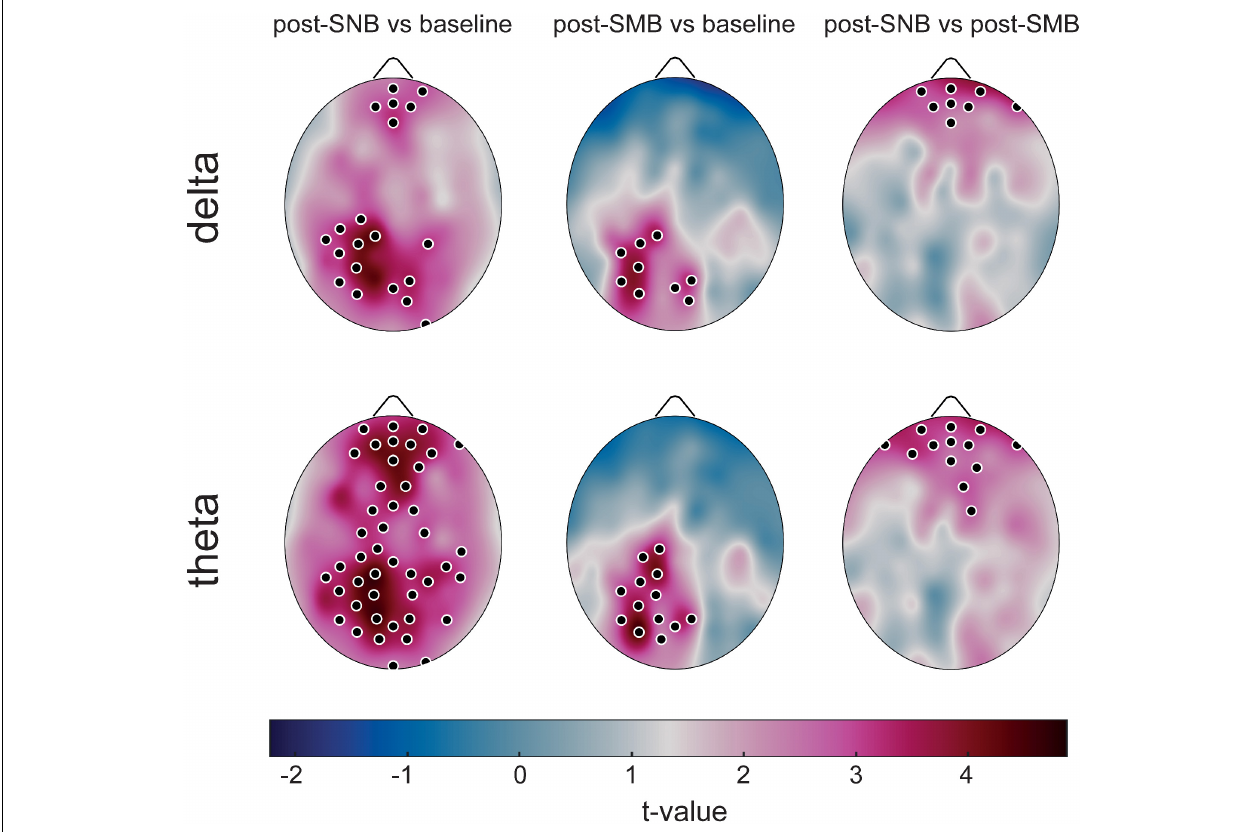
FIGURE 2 | Between-phase power spectral density differences at low frequencies. Scalp maps representing Power Spectral Density between-phase comparisons ( post-hocs ), are presented for delta and theta bands. For each between-phase comparison, the scalp plot denotes the electrode-wise t -value distribution related to the band and couple of phases. Electrodes showing a significantly higher value during the first phase, as compared to the second one, are identified by black